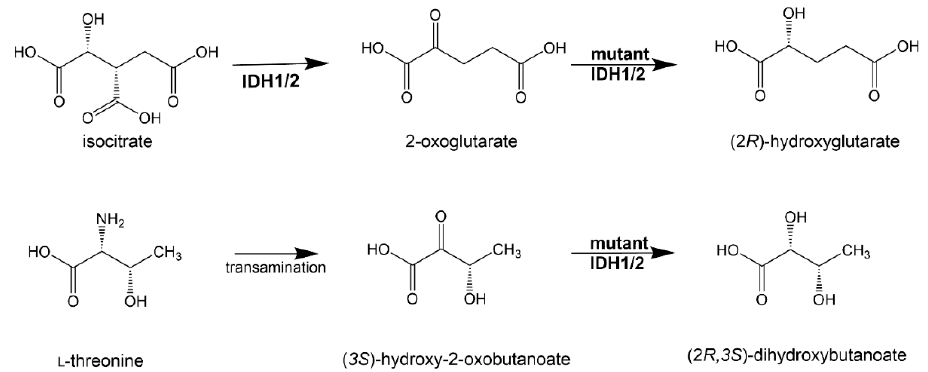
Figure 3. Structural relationship between the putative oncometabolite (2 R ,3 S )-dihydroxybutanoate, oncometabolite (2 R )-hydroxyglutarate, isocitrate and 2-oxoglutarate.